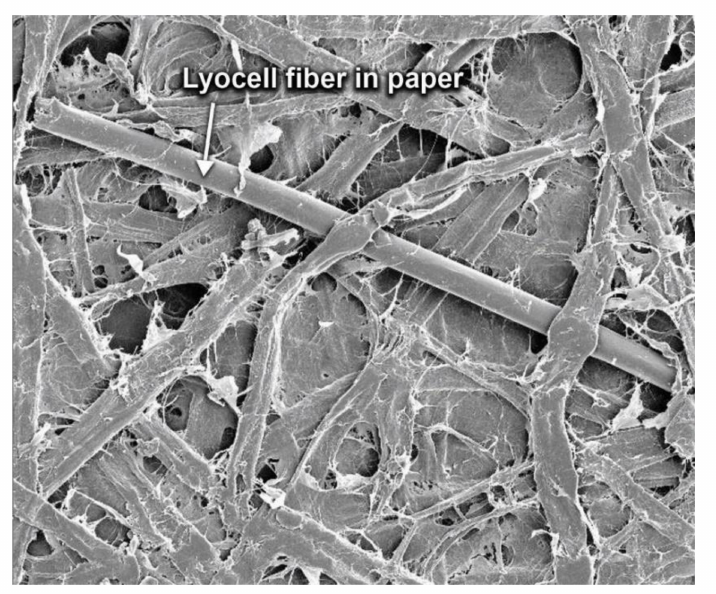
Figure 5. Graphic showing the lyocell fibers in paper structure prepared from Scanning Electron Microscopy (SEM)